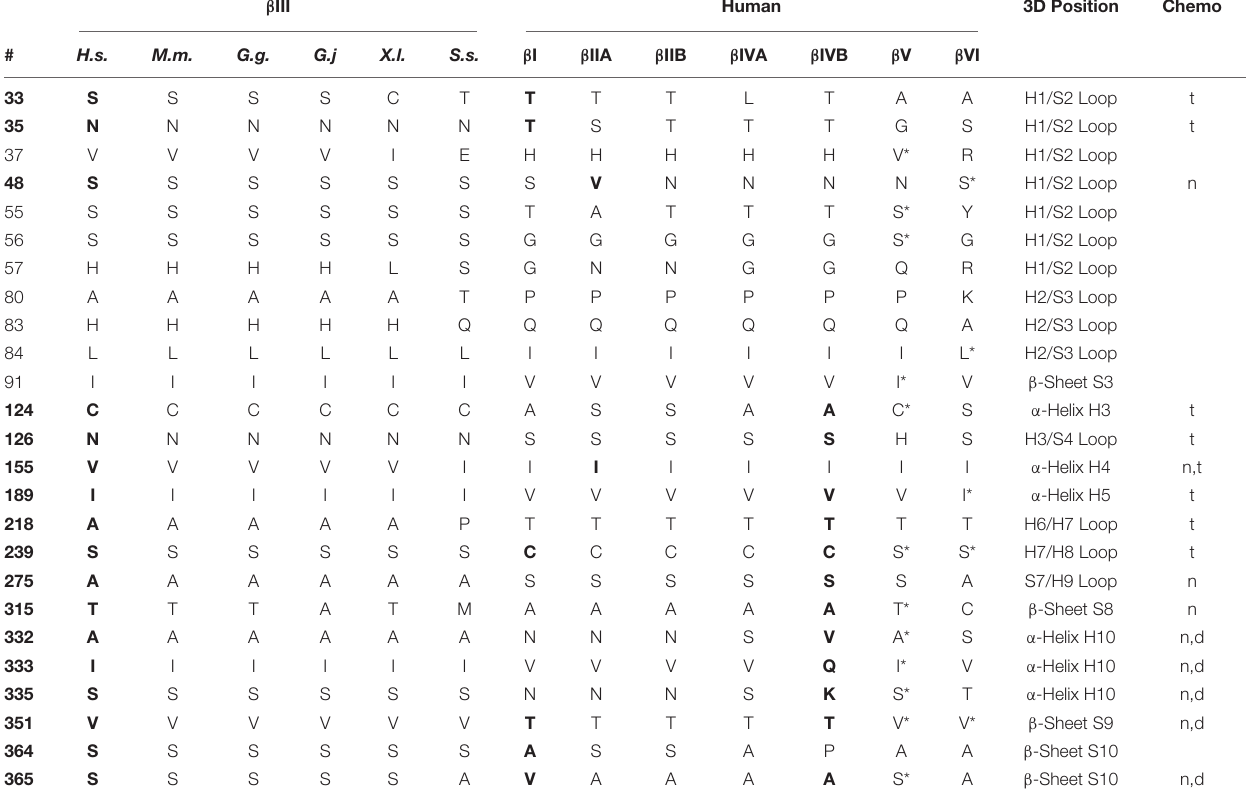
TABLE 1 | Unique, Conserved Positions in β III and their locations in the 3D Structure of Tubulin a . b . β III Human 3D Position